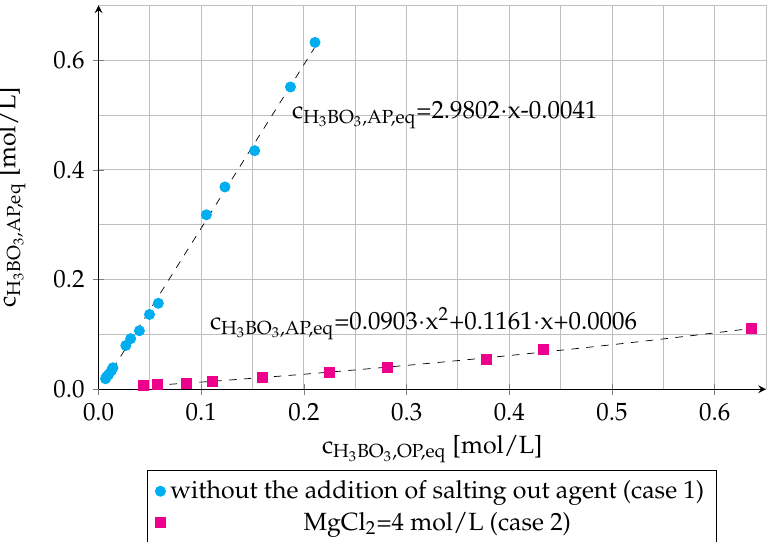
Figure 10. Experimentally determined relationship between the equilibrium concentration of boric acid in the aqueous and the organic phase for case 1 and 2 (experiment (4) , Table